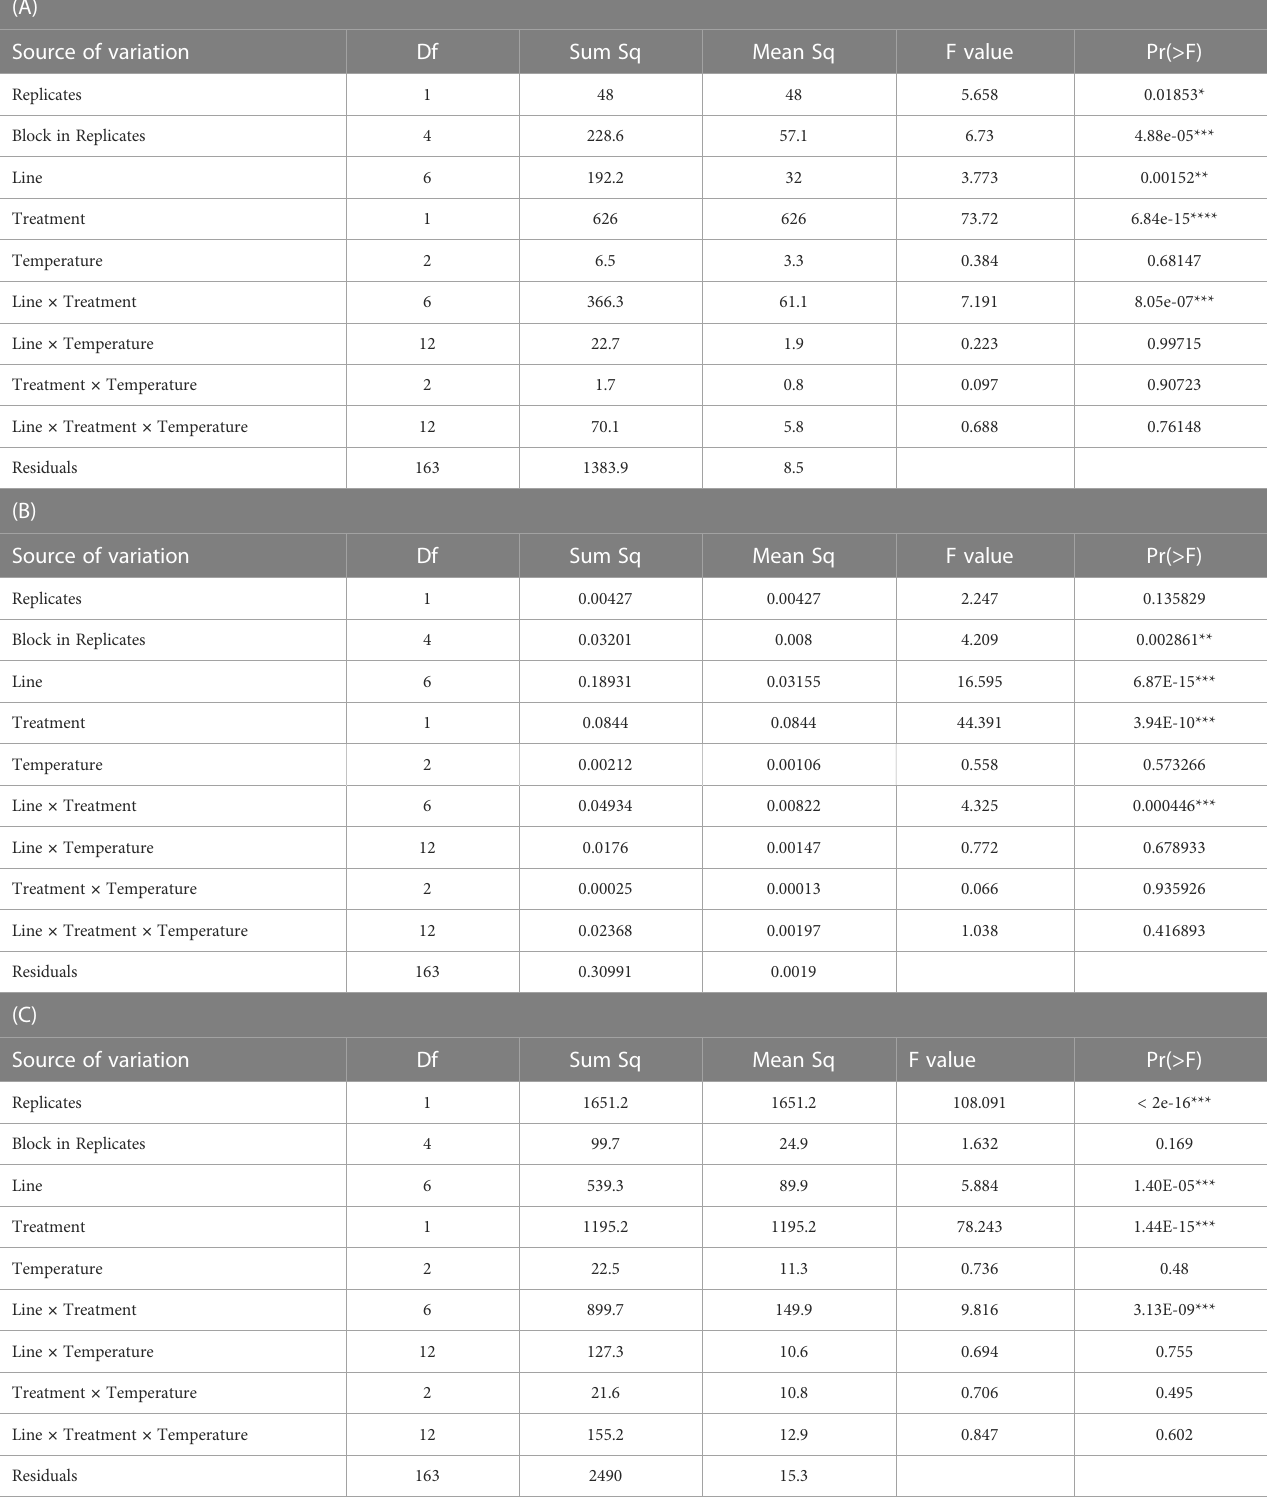
TABLE 3 Analysis of variance for fi tness